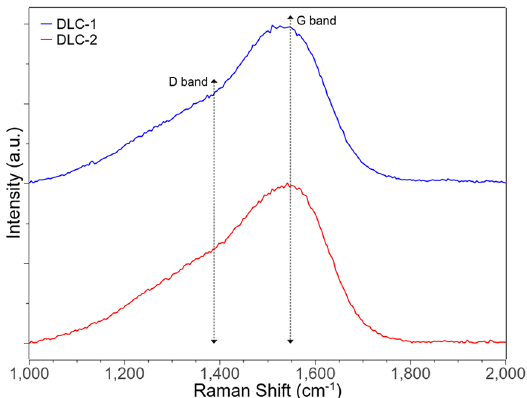
Figure 3. Raman spectroscopy highlighting D and G peaks as function of carbon bonds.